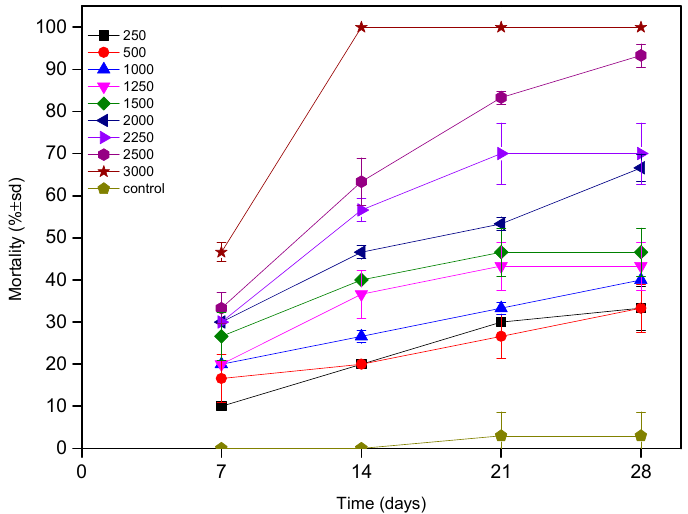
Figure 1. Mean mortality (% ± SD) of T. molitor adults sprayed with six concentrations of cyan- traniliprole after 28 days.